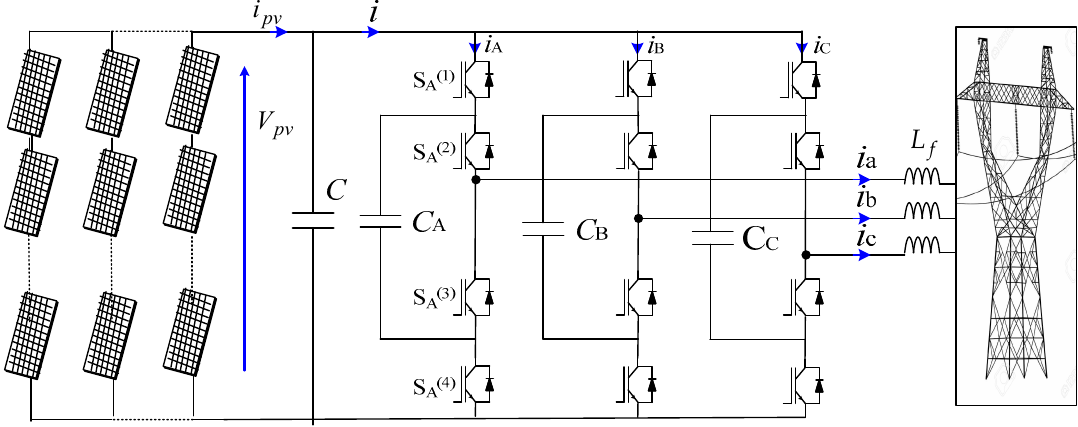
Figure 1. Three-phase grid-connected PV generation system based on three-level FC inverter.